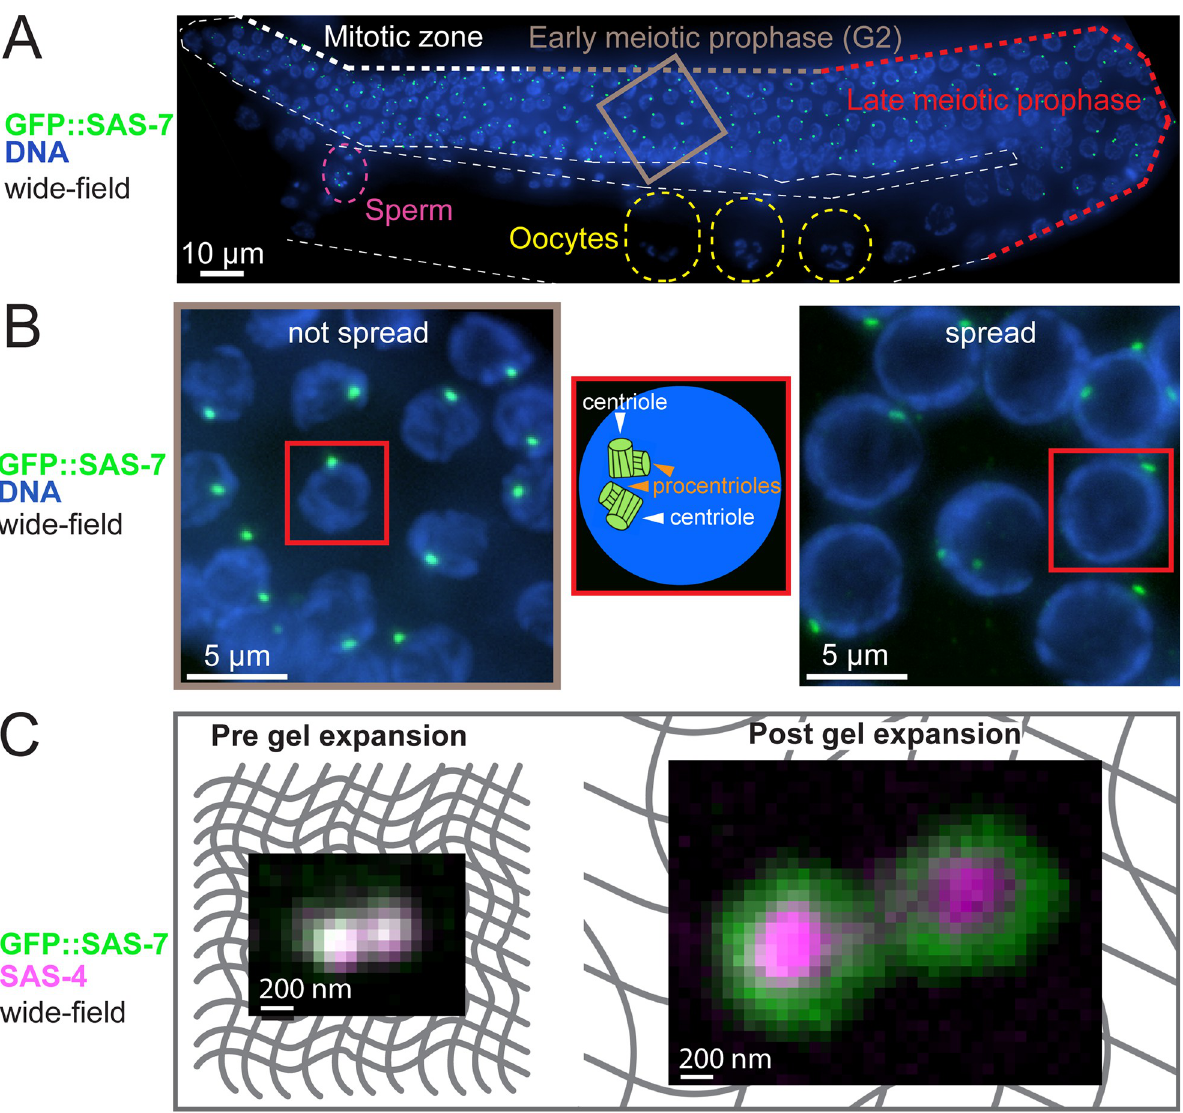
Fig 1. Combining gonad nuclei spreading and U-Ex microscopy to analyze worm gonad centrioles. (A) Widefield imaging of ethanol-fixed worm expressing GFP::SAS-7. One layer of nuclei of the gonad is max intensity Z-projected (in this case, a height of 6.25 μ m). White, grey, and red bold dashed lines indicate progression through the gonad from the mitotic zone to early and then late meiotic prophase; other white dashed line outlines the gonad. Grey box is magnified in (B). Yellow dashed regions mark 3 oocytes, purple dashed region the spermatheca. Note that centrioles are eliminated in oocytes, prior to fertilization. (B) (Left) Magnification of grey box region from (A). (Middle) Schematic representation of a single nucleus shown in the left and right panels. (Right) Early prophase region of a spread gonad from a worm expressing GFP::SAS-7. Note that spread nuclei are flattened and thus occupy a larger area compared to not spread nuclei. Note also that at this stage, centrioles do not act as microtubule organizing centers [55,56].(C) Widefield imaging of centrioles in the early prophase region of the gonad from worms expressing GFP::SAS-7 before (left) and after (right) gel expansion. Grey mesh in the background represents the gel